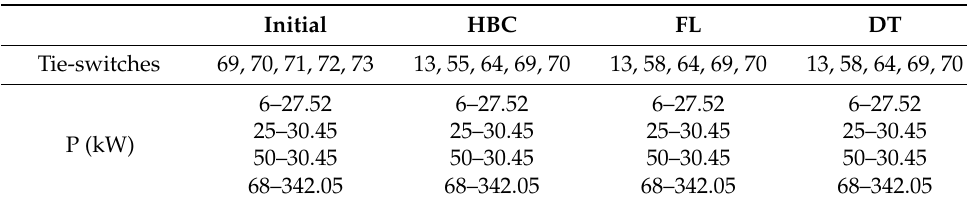
Table 3. Case with distributed generation: tie-switches of the configuration of the system and power